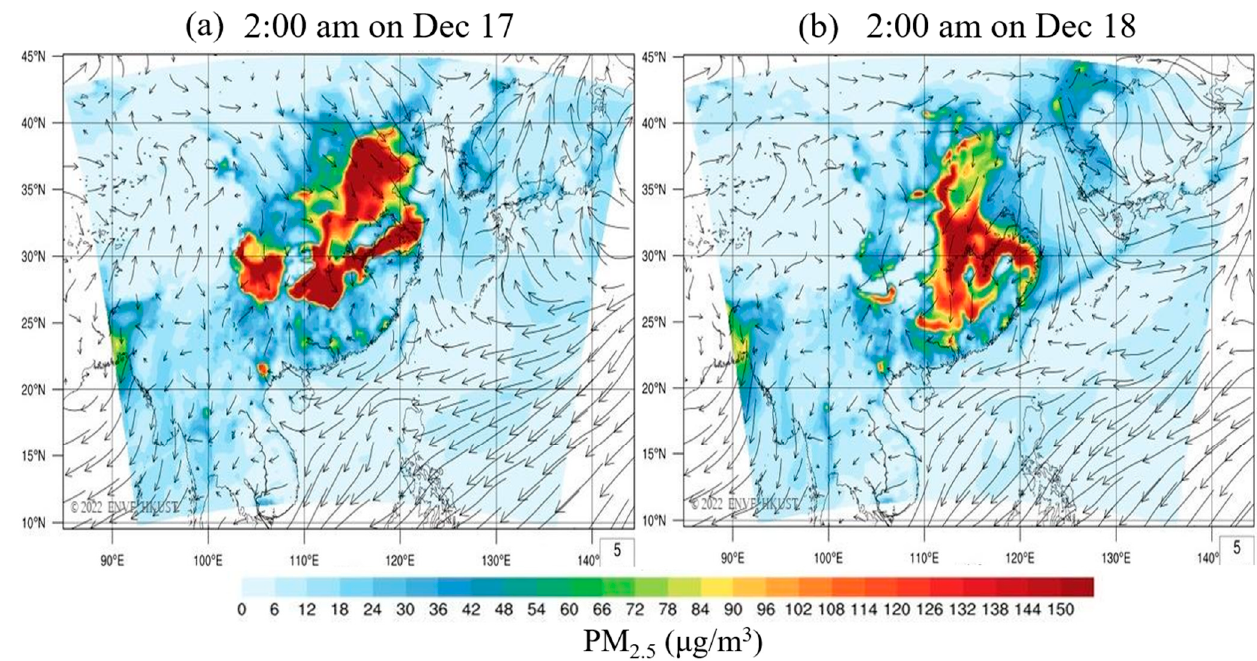
Figure 5. Spatial distributions of PM 2.5 concentrations in China at 2:00 a.m. LST on 17 December ( a ) and 18 December 2019 ( b ), from the WRF-CMAQ model simulations.